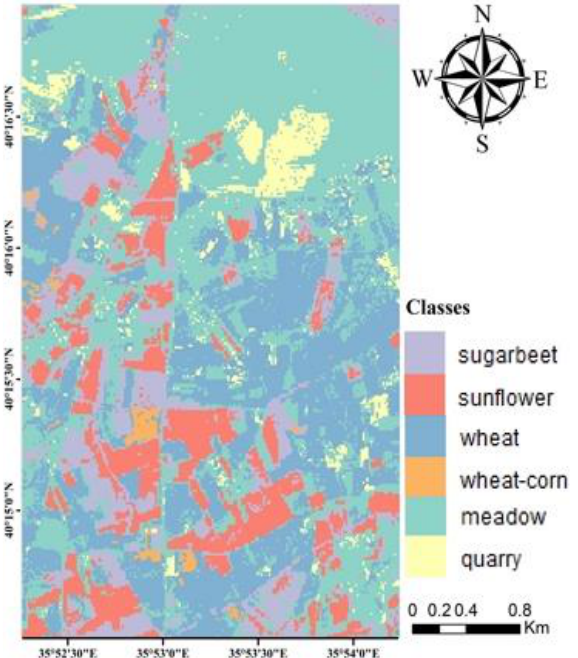
Figure 3. Cropland map classified by ϒ VV + ϒ VH , according to